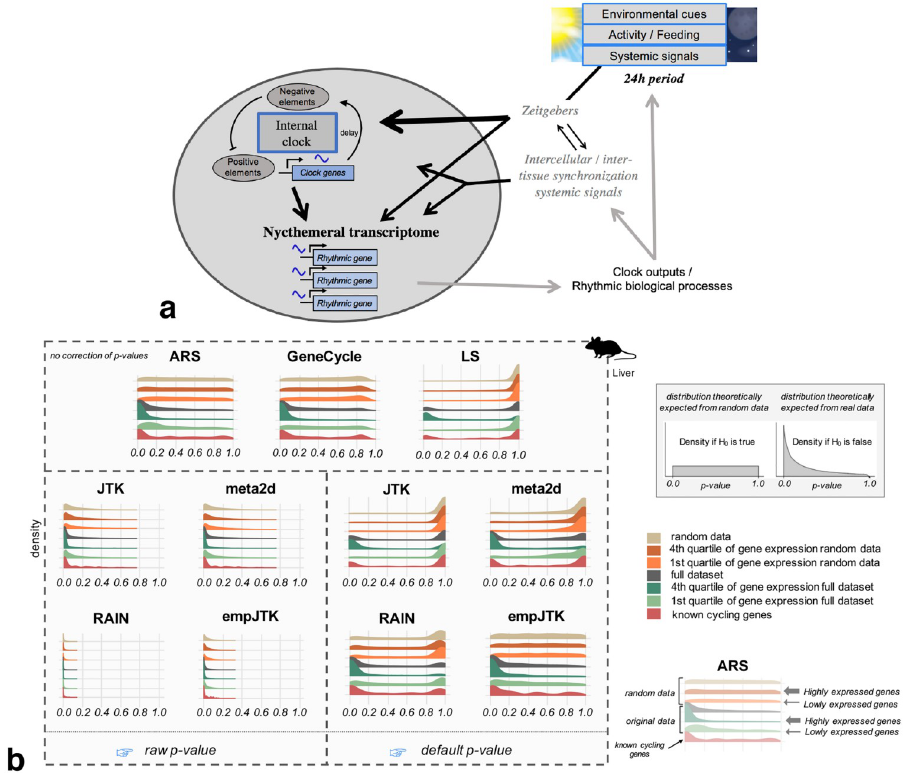
Fig 1. The nycthemeral transcriptome is the group of genes whose mRNAs have periodic variations with a 24h period, called rhythmic genes. To detect these rhythmic genes, we applied seven methods to time-series datasets that produced different density distribution of p -values. a) Simplified diagram of the entrainment of nycthemeral gene expression. Environmental cues include the light-dark cycle, food-intake, sleep-wake behavior, social activities, or any other 24h periodic event. b) Density distribution of p -values obtained before (raw) and after the default correction (software) for the seven methods applied to mouse liver data (microarray) sub-categorized in: i. randomized data which represents the null hypothesis; ii. randomized data restricted to the first and fourth quartiles of the median gene expression level, to check for the impact of expression level under the null; iii. the full original dataset; iv. the first and fourth quartiles of the median gene expression level of the original data; and v. a subset of known cycling genes (99 genes from KEGG “circadian entrainment” among which we expect a large proportion of rhythmic mRNA accumulation). The default p -values of ARS, GeneCycle, and LS are uncorrected. Mouse image credit to Anthony Caravaggi (license CC BY-NC-SA